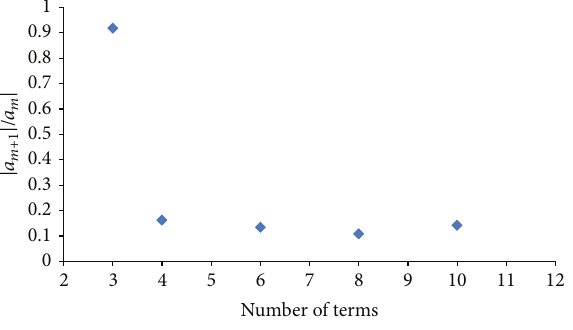
Figure2:Theratioconvergencetestappliedtotheseriescoefficients (ECM) for MDM and HPM as a function of the number of terms in series.